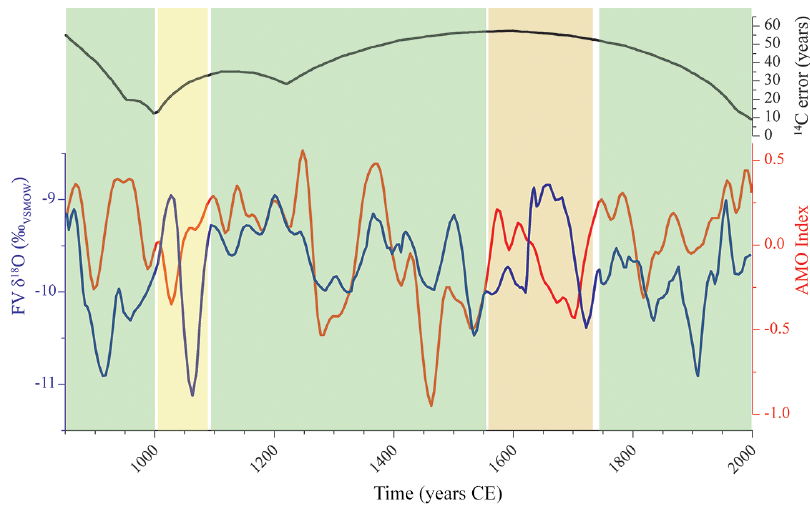
Figure 7. Temporal variability of the FV δ 18 O (blue), the reconstructed AMO index (Wang et al., 2017), and the 14 C measurement uncer- tainty between 850 and 2000CE. Shading indicates the offset (in years) between the FV δ 18 O and AMO index values: green denotes less than 20 years, yellow denotes between 20 and 50 years and orange denotes above 50